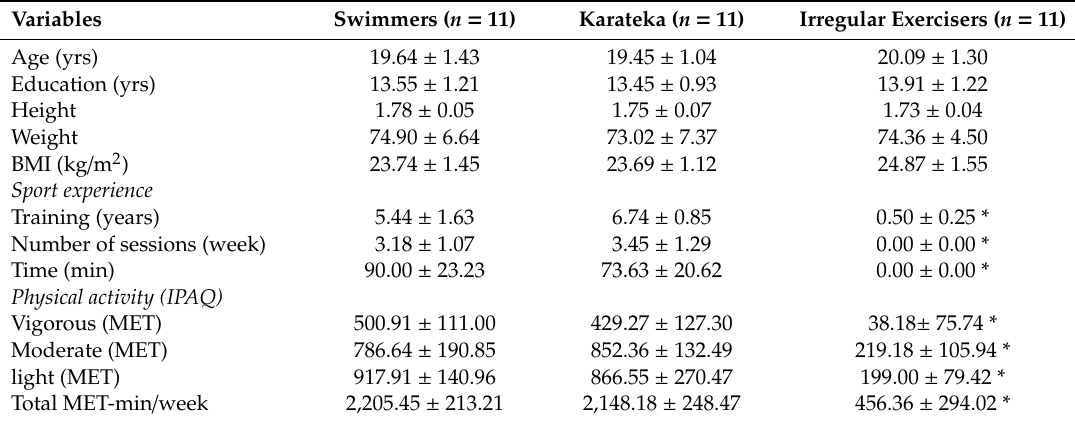
Table 1. Descriptive data for participants’ demographic and physical characteristics among three groups (mean ± SD).